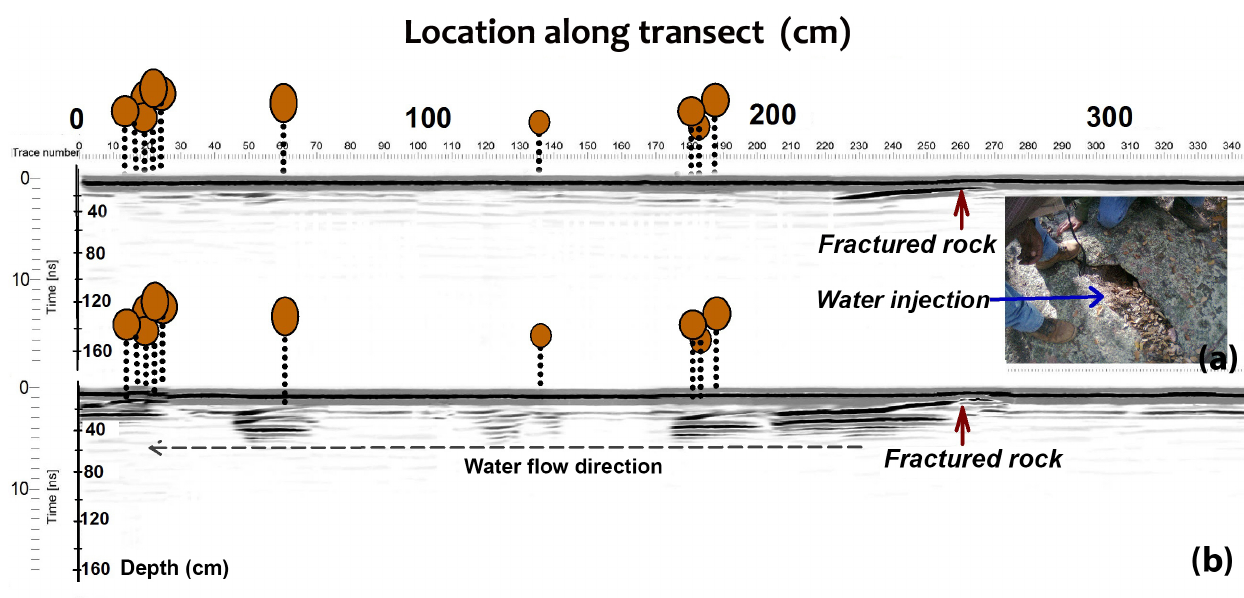
Figure 6. GPR radargrams showing how oak roots are preferentially located in fractured rocks where the probability of water accumulation is high. (a) GPR radargram in dry conditions. (b) GPR radargram 150min after the injection of 15L of water in a rock fracture. In the radargrams filters were applied to highlight areas of interest. Inserted photo: rock fracture, where water was injected.